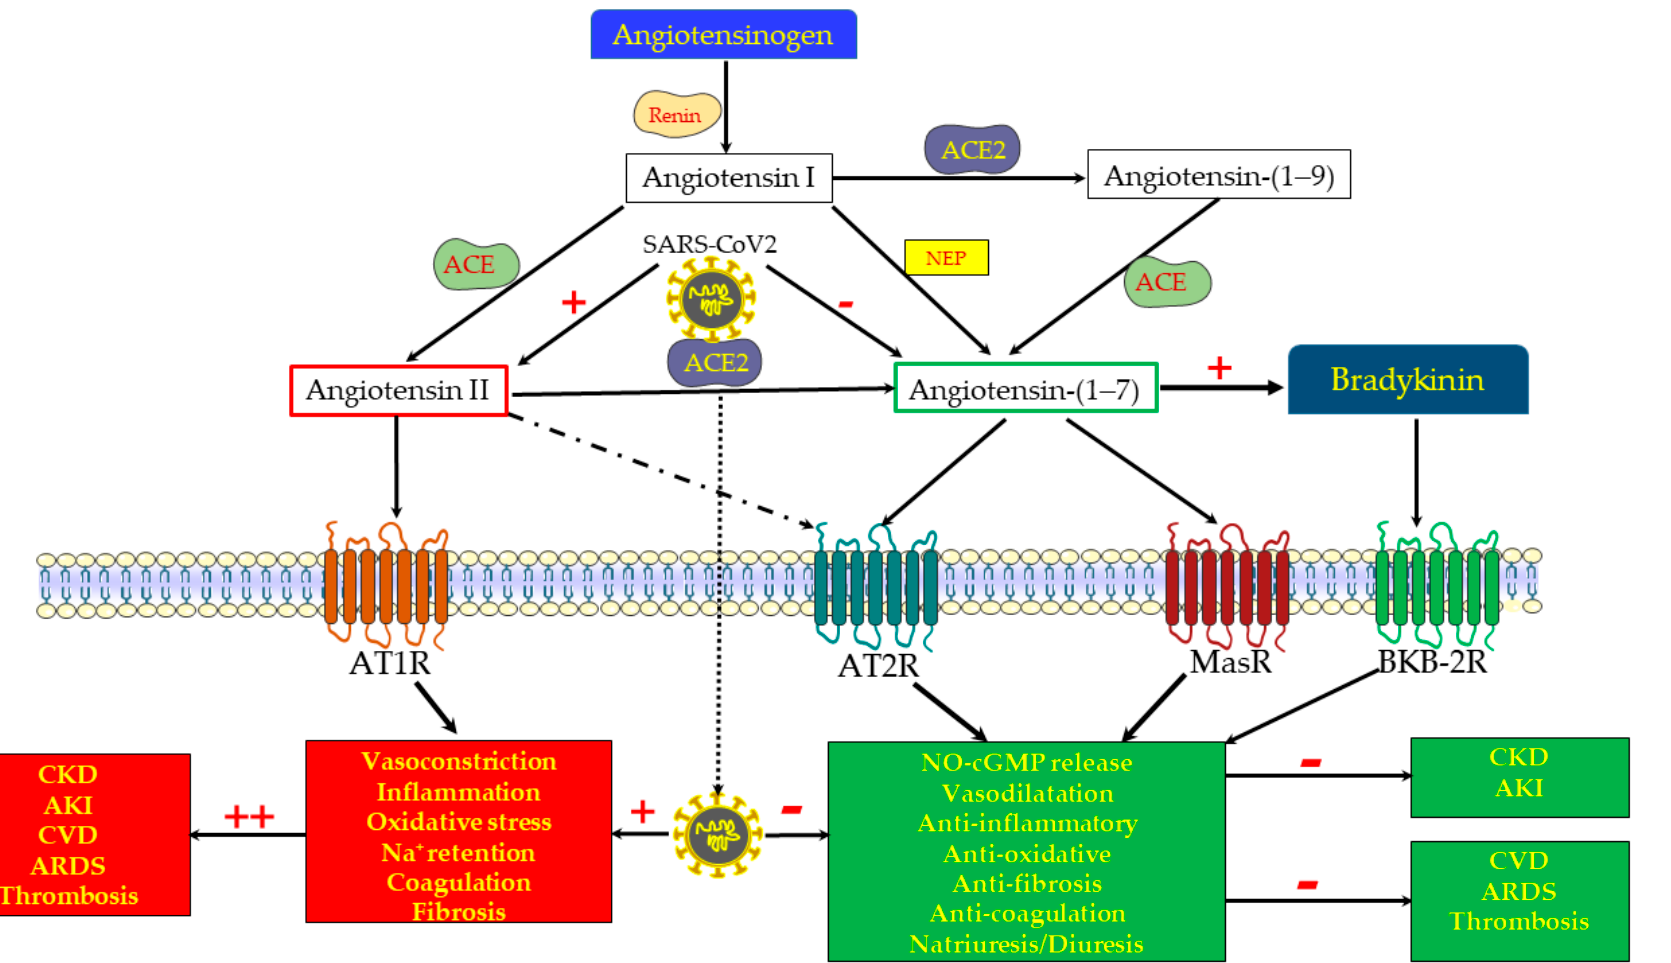
Figure 1. Biosynthesis and functional scheme of the renin–angiotensin system (RAS). The classical RAS consists of the protease renin, which is secreted from renal juxtaglomerular cells adjacent to the afferent arteriole, and which acts on the circulating precursor angiotensinogen to generate angiotensin (Ang) I, an inactive 10 amino acid (aa) peptide. The latter is converted by the angiotensin-converting enzyme (ACE) to Ang II, an 8 aa active peptide. Ang II is the main effector component